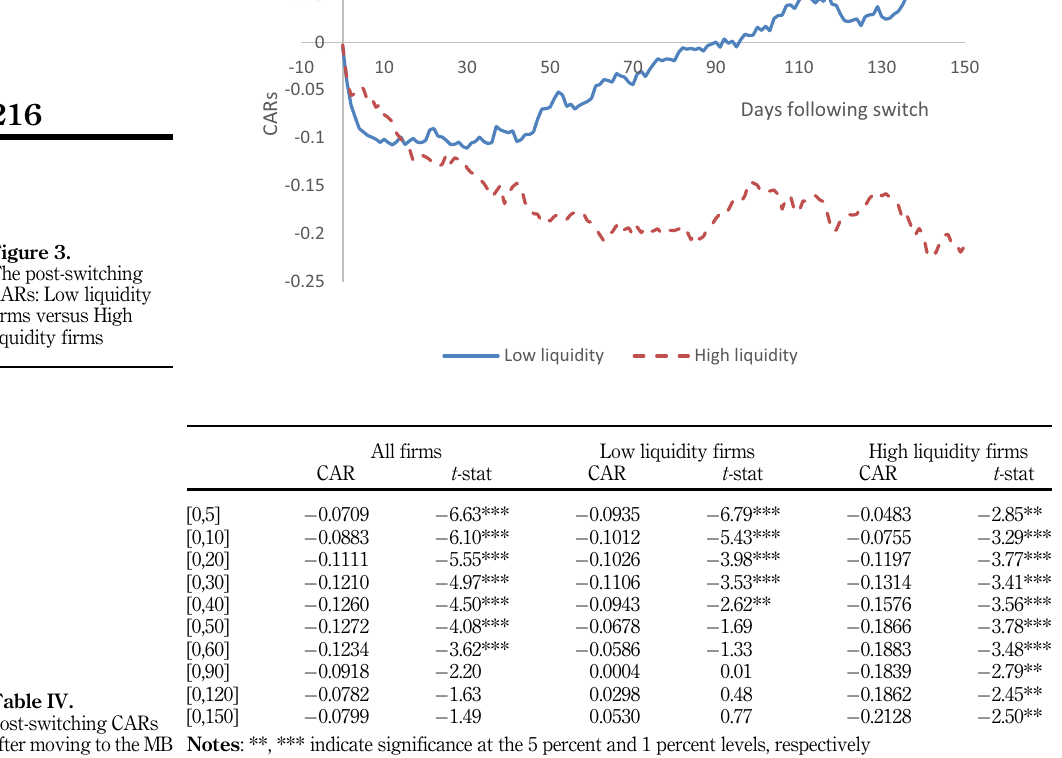
Table IV. Post-switching CARs after moving to the